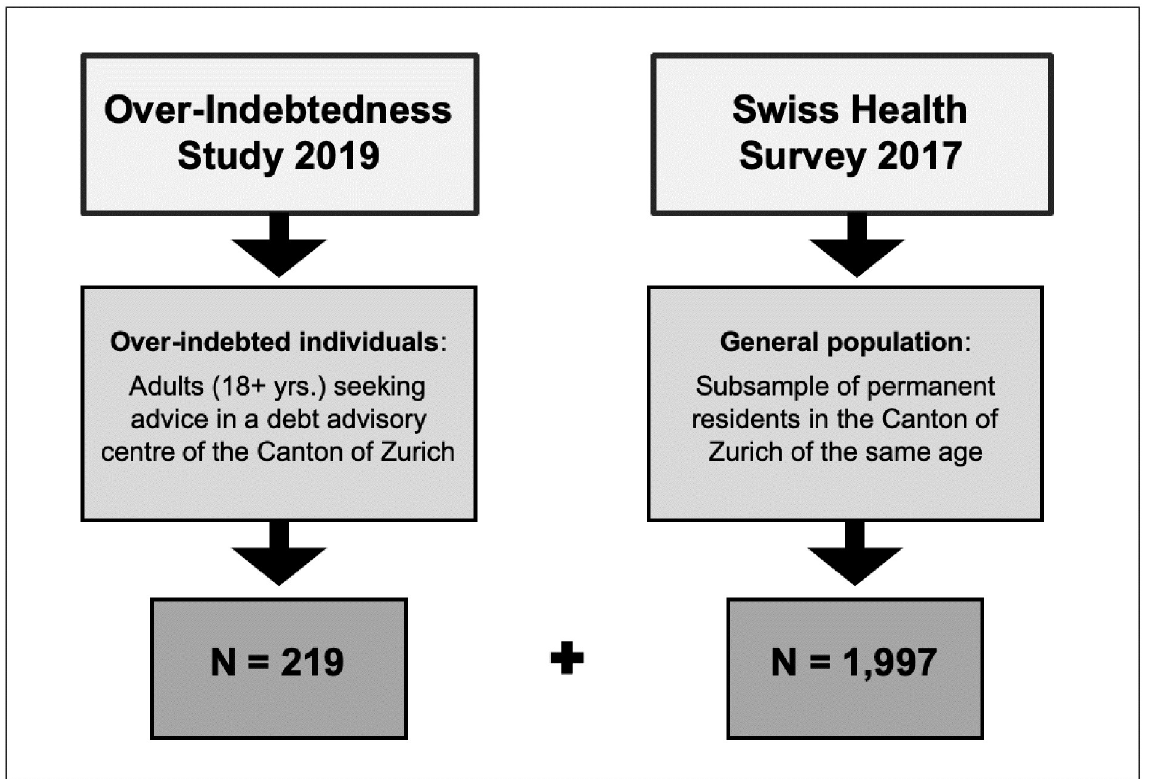
Fig 1. The study population: An aggregation and combination of two randomly selected samples of over-indebted individuals and the general population in the Canton of Zurich.